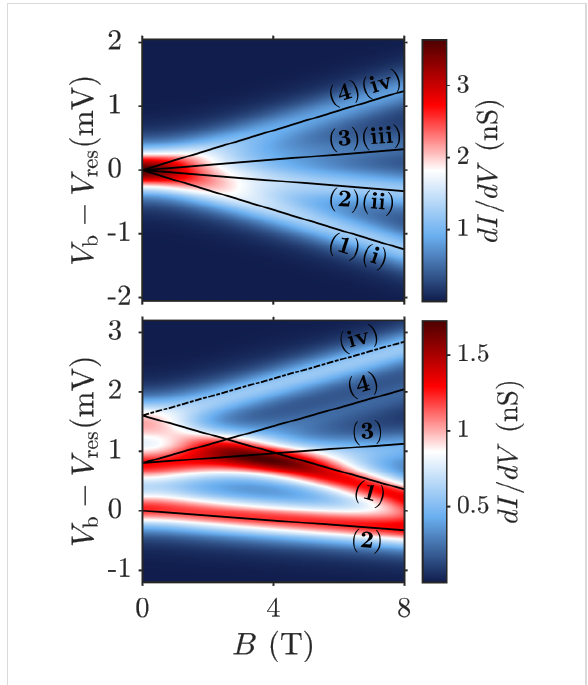
Figure 5: Differential conductance maps as a function of the strength B z of the magnetic field in z -direction. Upper (lower) panel: Spin–orbit interaction switched off (on). Solid and dashed lines depict the add- ition spectrum as calculated from the effective spin Hamiltonian, cf. Equation 28. Transitions starting from the neutral groundstate are denoted by solid lines, those from the neutral excited state by dashed